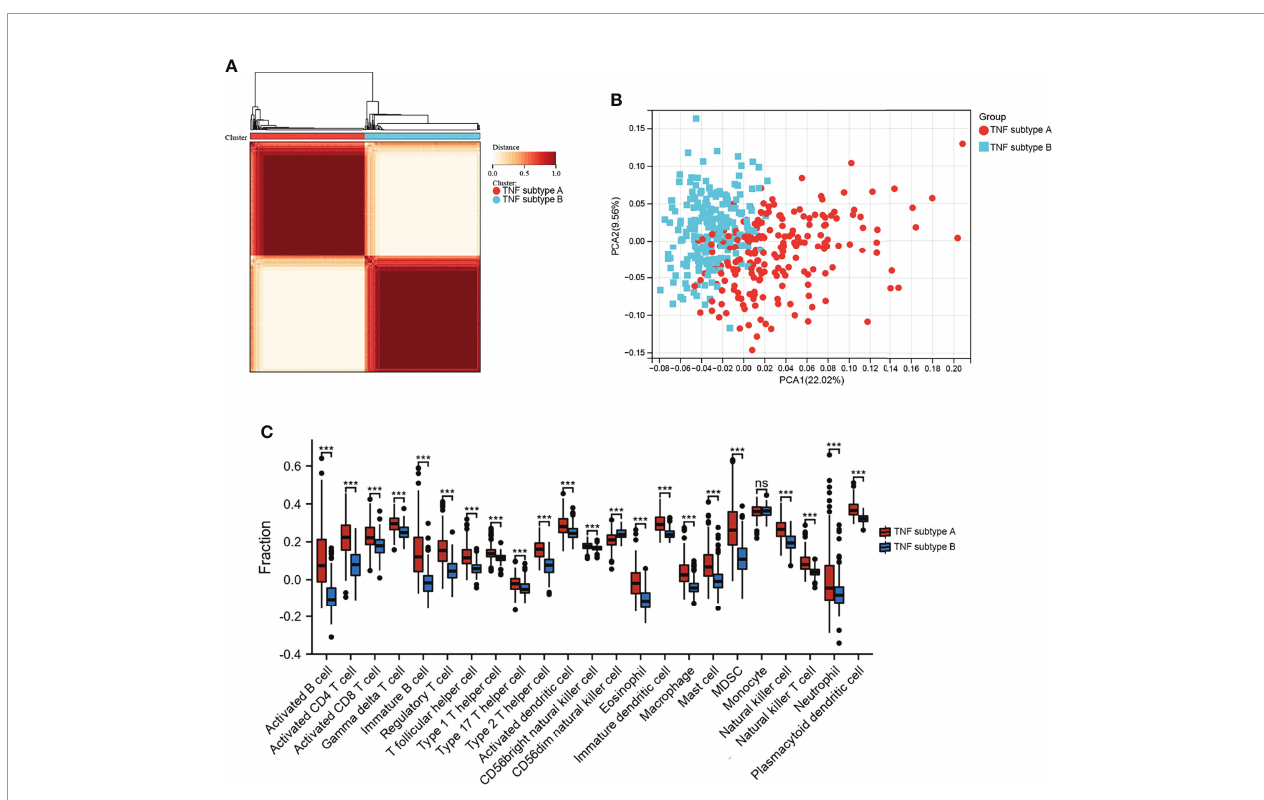
FIGURE 2 | Identi fi cation of TNF subtypes in CD. (A) Consensus clustering matrices of 43 TNF family genes in CD merged dataset (k = 2). (B) PCA for the expression of 43 TNF family genes to distinguish two TNF subtypes in CD merged dataset. (C) In fi ltration fraction of Immune cells in two TNF subtypes (***p < 0.001; ns, not signi fi